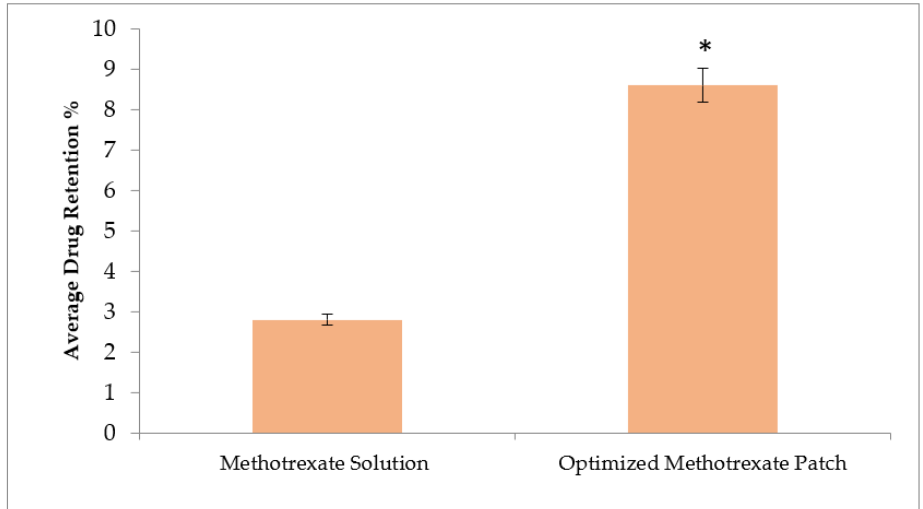
Figure 7. Methotrexate concentration in the skin from the methotrexate solution and methotrexate-optimized patch formulation (F9). Data are expressed as mean ± SD; n = 3. One-way ANOVA followed by post hoc Tukey Test ( p < 0.05).